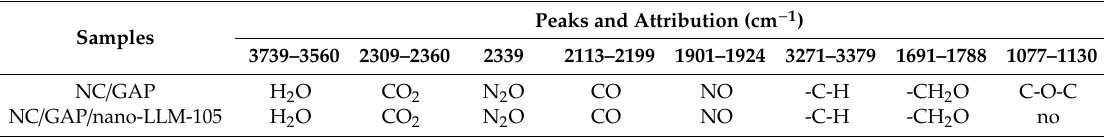
Table 4. Peaks and